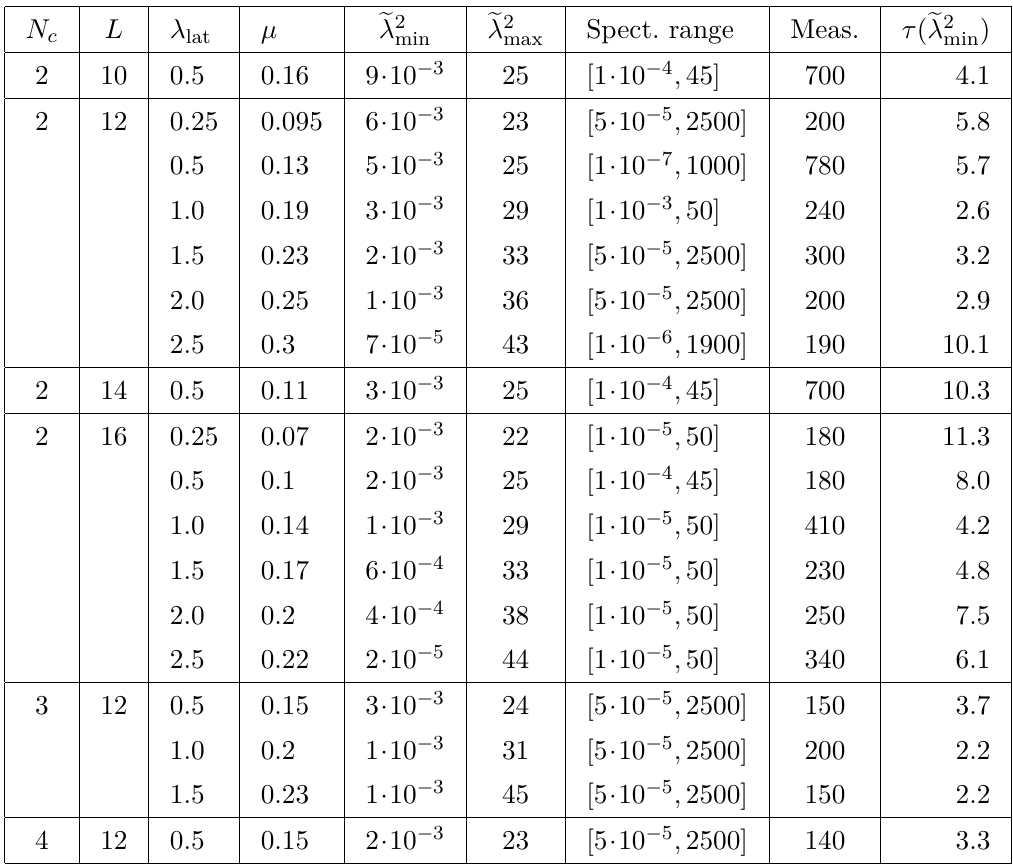
Table 1. Summary of the ensembles we consider, with gauge group U( N c ) and lattice volume L 4 . For all ensembles G = 0 . 05 and the fermion fields are subject to antiperiodic BCs in the √ time direction. We set µ ≈ 5 λ lat /L to remove the scalar potential in eq. (2.2) in the L → ∞ continuum limit with fixed lattice ’t Hooft coupling λ lat . For each ensemble we report the extremal eigenvalues e λ 2 of e D † e D , ensuring that they remain within the spectral range where the corresponding RHMC rational approximation is accurate. The listed number of mode number measurements are carried out on thermalized configurations separated by 10 molecular dynamics time units. From measurements of e λ 2 on those same configurations we also estimate autocorrelation times τ in min units of